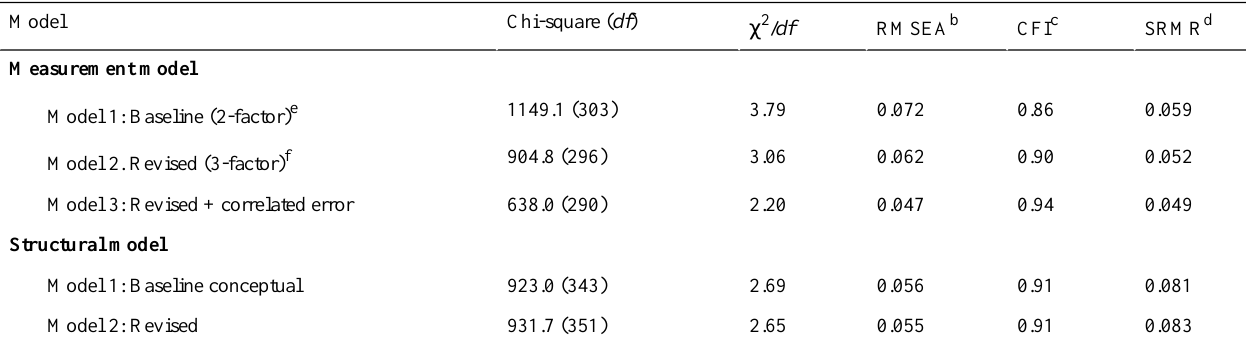
Table 3. Model fit statistics.